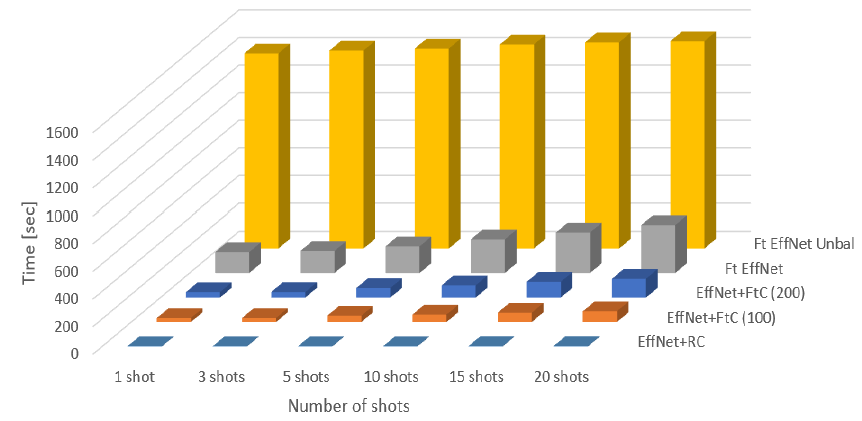
Figure 9. Elapsed training time of the different models under